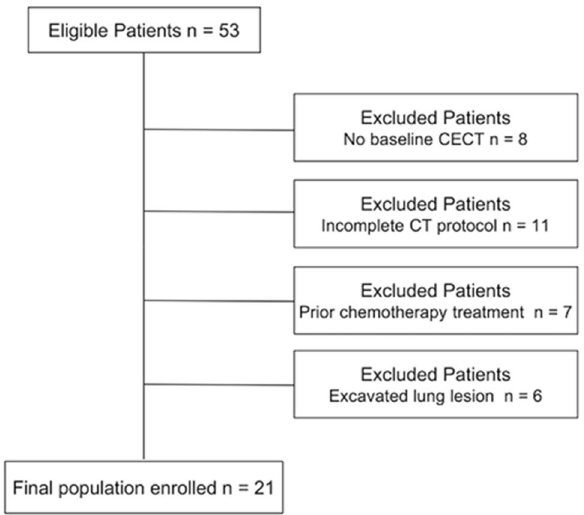
Figure 1. Final population enrollment